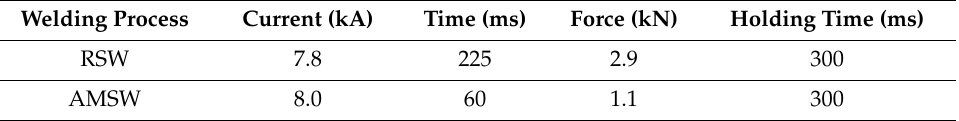
Table 5. Optimized welding parameters for the execution of the experiments.